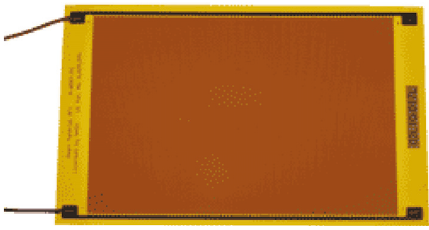
Figure 3: Macro fibers